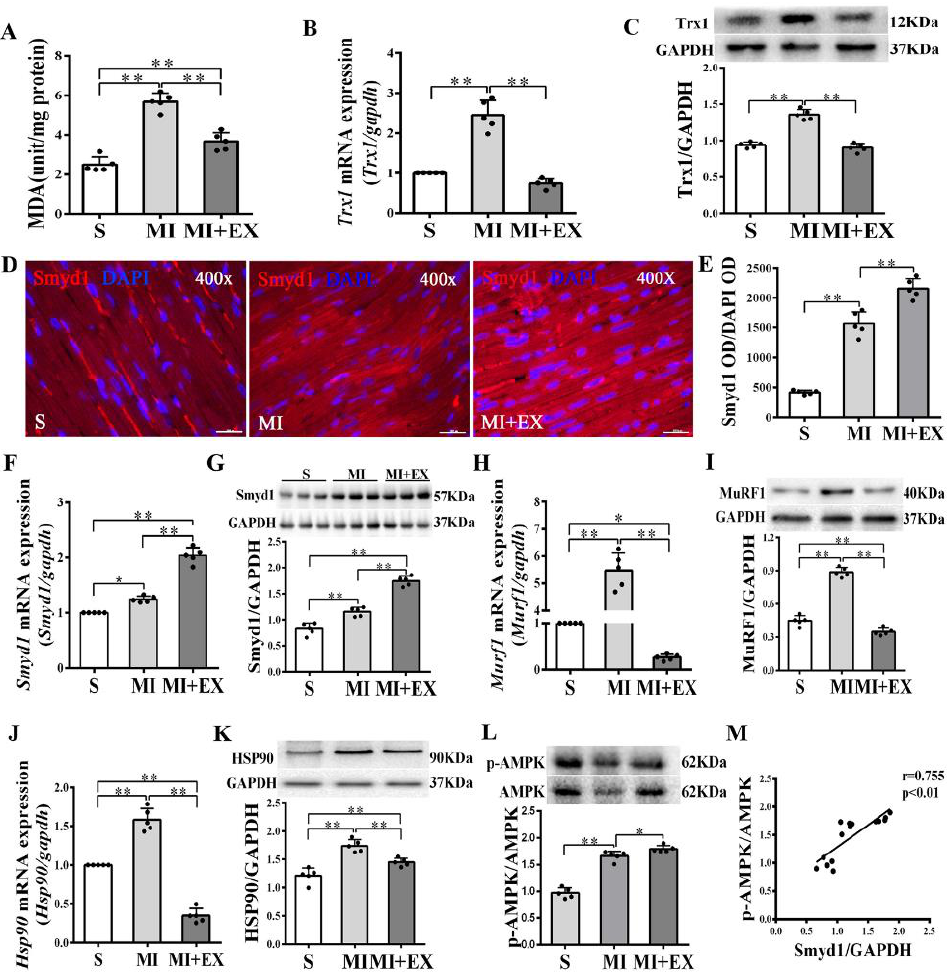
Figure 2. mRNA and protein expression of Smyd1 (SET and MYND domain containing 1), Trx1 (thioredoxin 1), MuRF1 (muscle RING-finger protein-1), and HSP90 (heat shock protein 90) and antioxidant capacity in the post-MI rat hearts: ( A ) Malondialdehyde (MDA) content in the infarcted myocardium; ( B , C ) mRNA level assessed by RT-qPCR ( B ) and protein level assessed by Western blot ( C ) of Trx1 in the infarcted myocardium; ( D ) immunofluorescent staining with Smyd1 (red color) and DAPI (blue color) in the sections from peri-infarcted area of heart (scale bar = 100 µm); ( E ) Integrated optical density (IOD) of Smyd1 (as a ratio normalized with IOD of DAPI); ( F , G ) Smyd1 mRNA levels assessed with RT-qPCR ( F ) and Smyd1 protein expression assessed with Western blots ( G ) in the heart; ( H – K ) mRNA assessed with RT-qPCR ( H , J ) and protein expression assessed with Western blots ( I , K ) of MuRF1 and HSP90 respectively in the heart tissues; ( L ) the ratio of phosphorylated AMPK (p-AMPK) and total AMPK protein expression; and ( M ) correlation analysis among Smyd1 expression and the ratio of p-AMPK / AMPK. Data are expressed as mean ± Standard Deviation (SD), n = 5 / group (graphs A to L, except D) or n = 15 / group ( M ). Symbols indicate * p < 0.05 and ** p < 0.01. Abbreviations: S, Sham group; MI, MI alone group; and MI + EX, post-MI exercise training group.